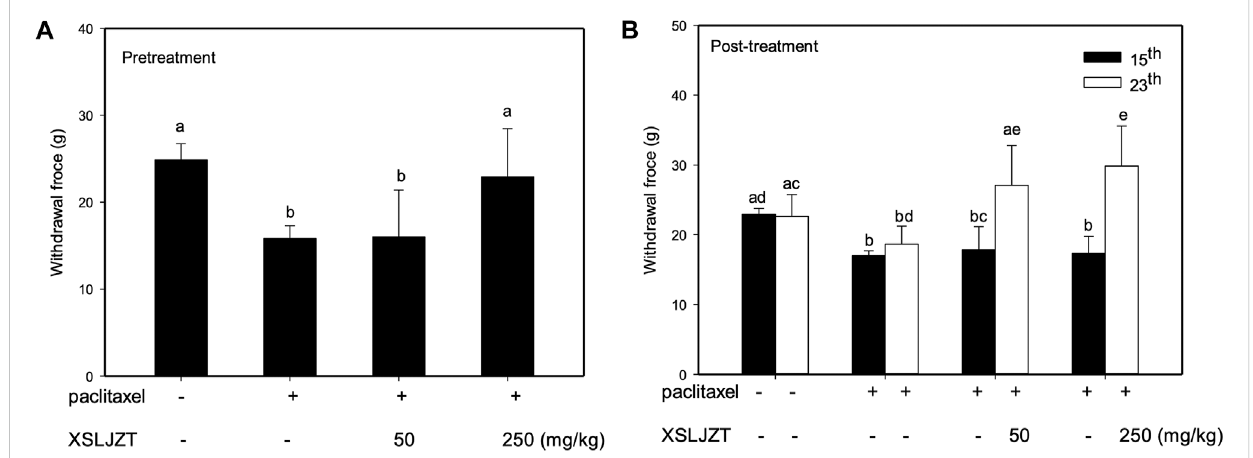
FIGURE 5 Anti-mechanicalallodyniaeffectsofXSLZJTonpaclitaxel-inducedneuropathyinrats. (A) ,pre-treatmenteffectsofXSLJZT(50or250 mg/kg)onthe von frey test results on day 15; (B) , post-treatment effect of XSLJZT on the Von Frey test results on day 15 and day 23 as compared to the control group. The different alphabets show a signi fi cant ( p < 0.05) difference between each other.